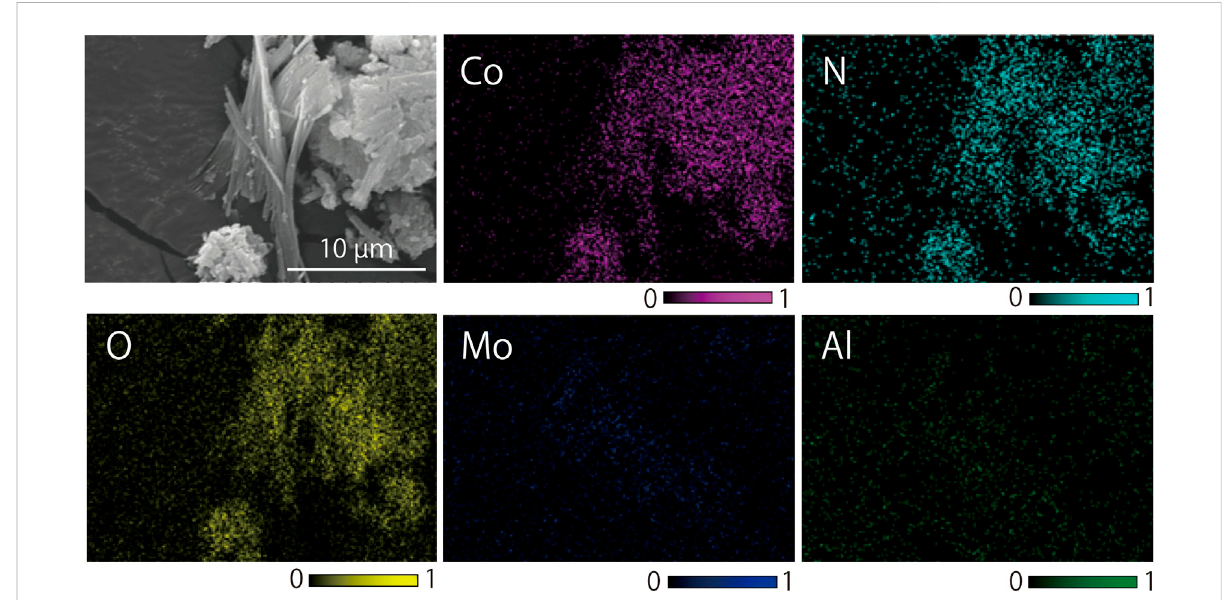
FIGURE 6 SEM-EDSelemental mappingofCo-Alacomplexformedintheactualspentcatalyst leachate(spentcatalystparticlesseparatedpriortoCo-Ala precipitation) at 45 ° C (corresponding to Figures 5C,C ′ ): The secondary electron image was mapped for Co, N, O, Mo and